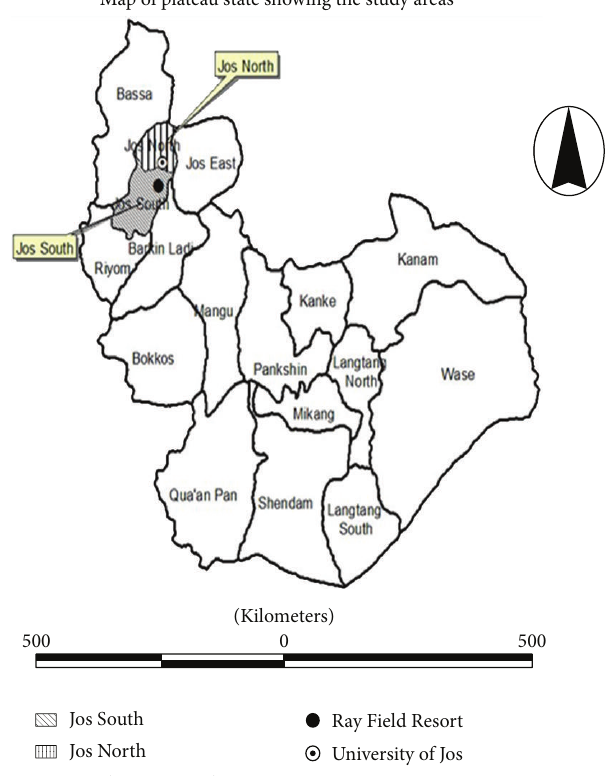
Figure 1: Map of Jos showing Jos North and South Local Gov- ernment Areas among other Local Government Areas in Plateau State, Nigeria (Source: